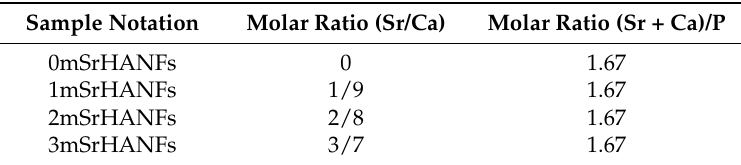
Table 1. Sample notation and molar ratio for the fabrication of strontium-substituted hydroxyapatite nanofibers with a mesoporous structure